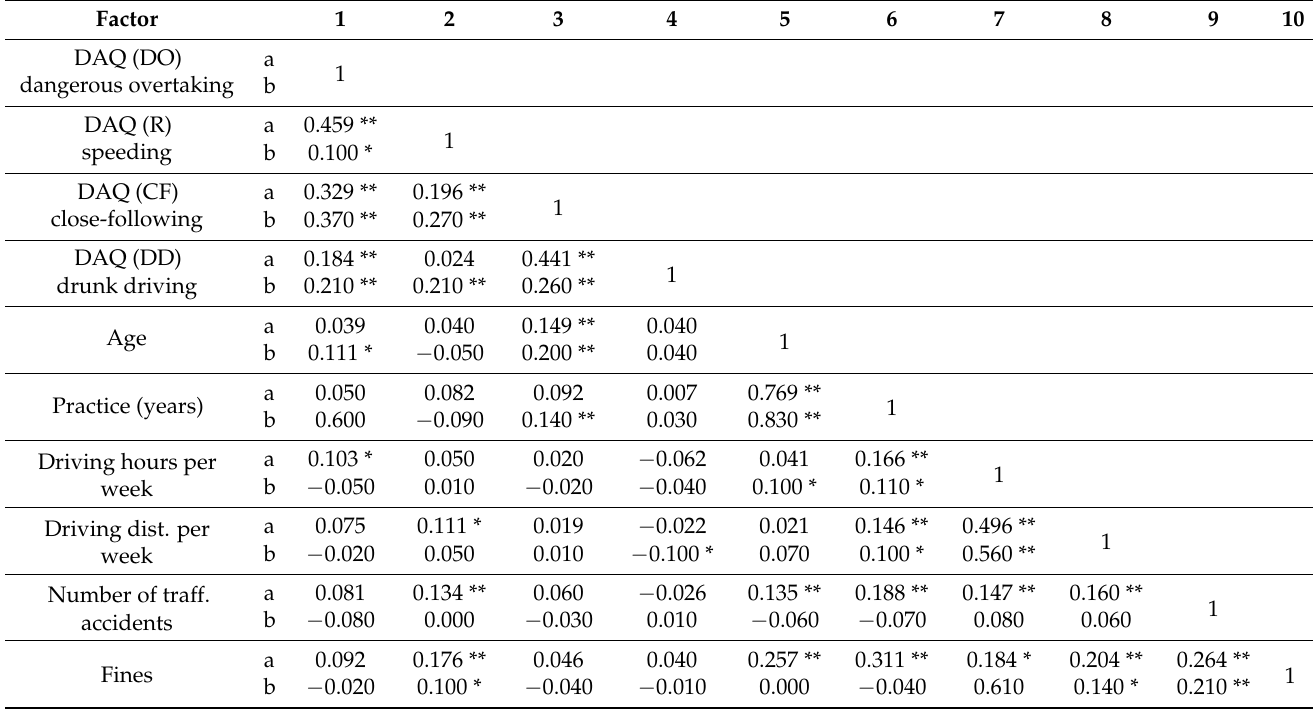
Table 4. DAQ correlation matrix and comparison with a foreign study. Abbreviations: a = own study; b = comparative study. Source: [32], processed by